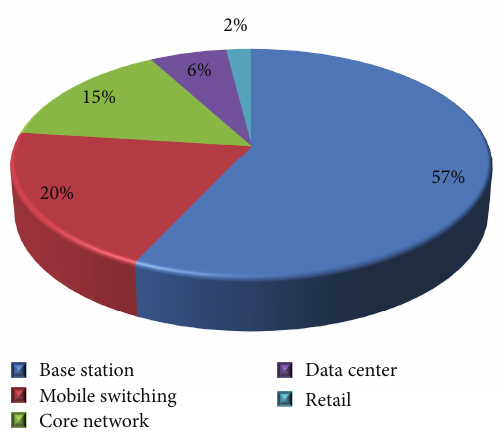
Figure 3: Energy consumption composition of a mobile operator.